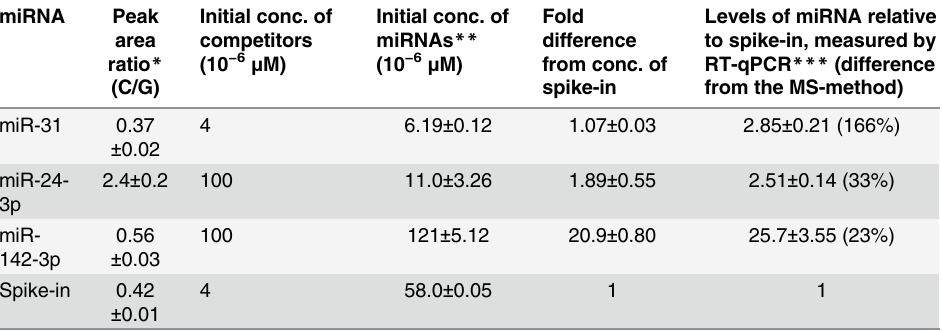
Initial conc. of miRNAs ** (10 − 6 μ M)